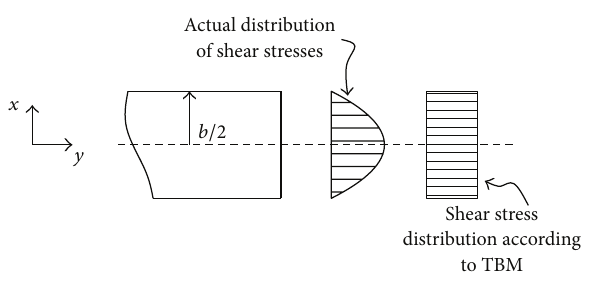
Figure 3: Homogeneous condition of transverse stress components at the free boundaries.